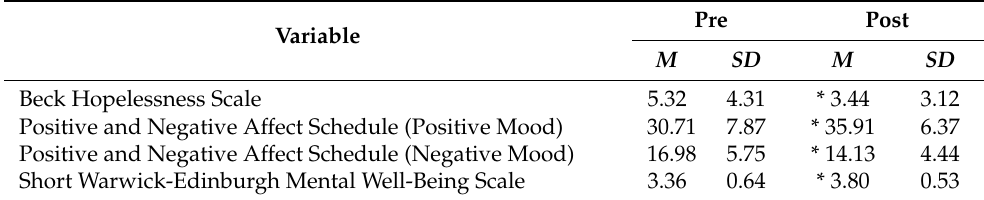
Table 2. Pre and post scores for repeated-measures t test on hopelessness, mood, and well-being (N = 79).